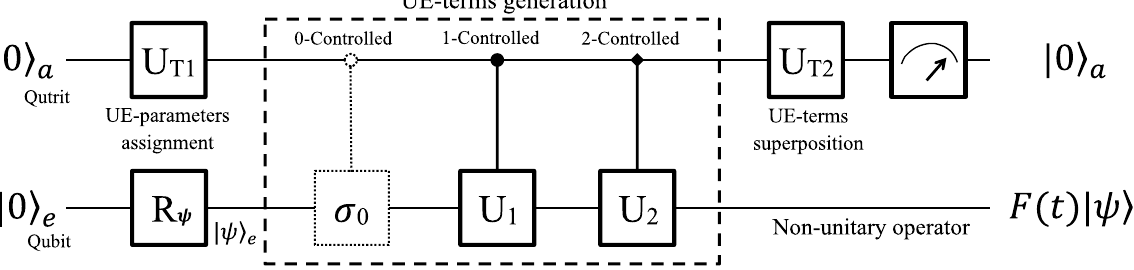
0 0 a e , and the | � | �